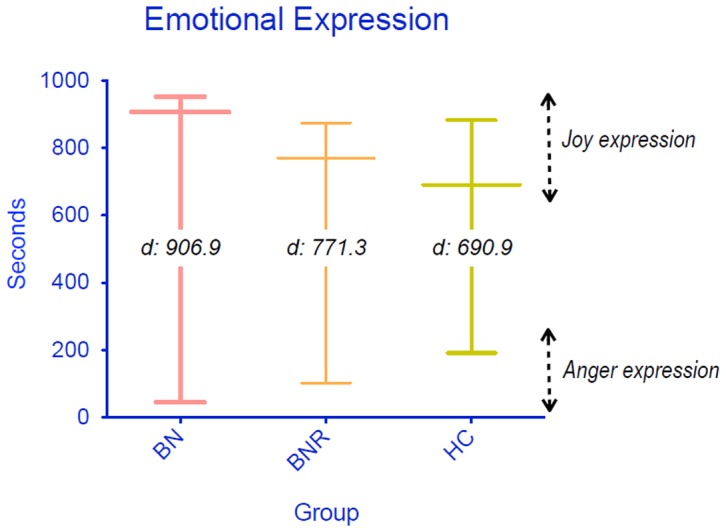
Average difference between positive and negative implicit emotional expression among the groups.